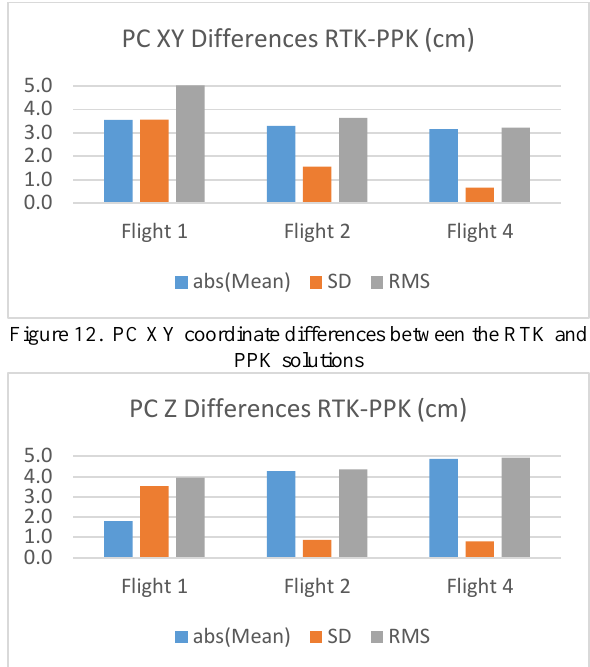
Figure 13. PC Z coordinate differences between the RTK and PPK